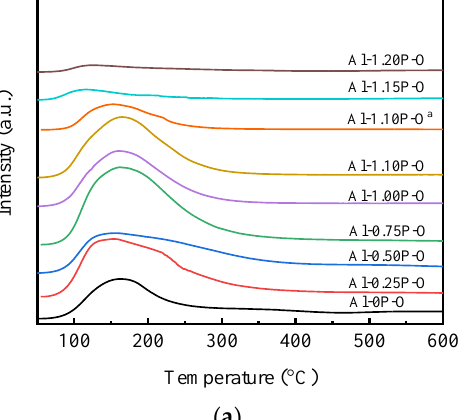
Figure 5. ( a ) NH 3 -TPD and ( b ) CO 2 -TPD profiles of Al- x P-O and Al-1.1P-O a samples.